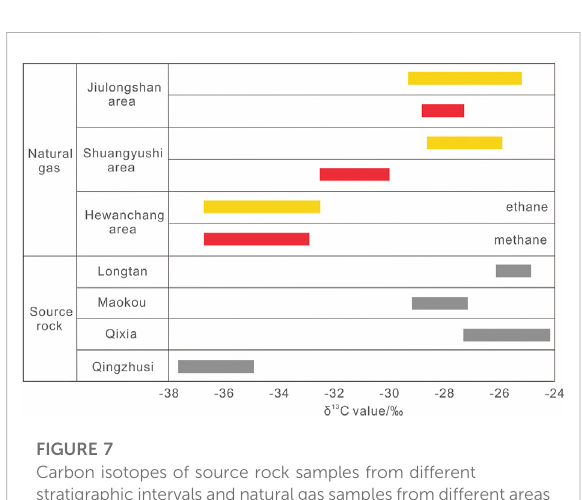
FIGURE 7 Carbon isotopes of source rock samples from different stratigraphic intervals and natural gas samples from different areas to indicate the origins of natural gas.